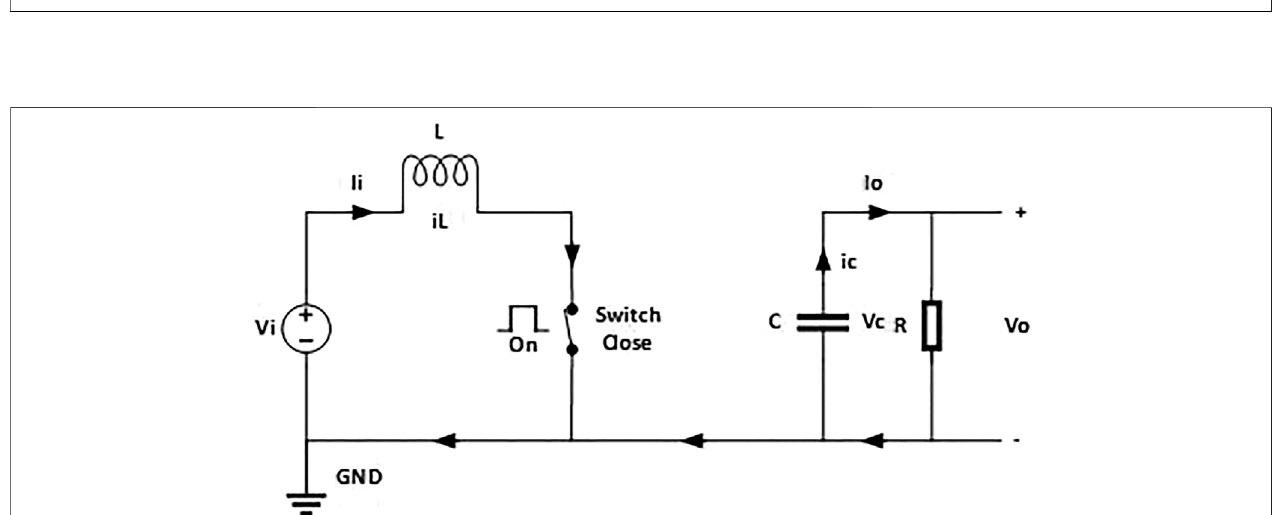
FIGURE 2 | Circuit of DC-DC boost converter.